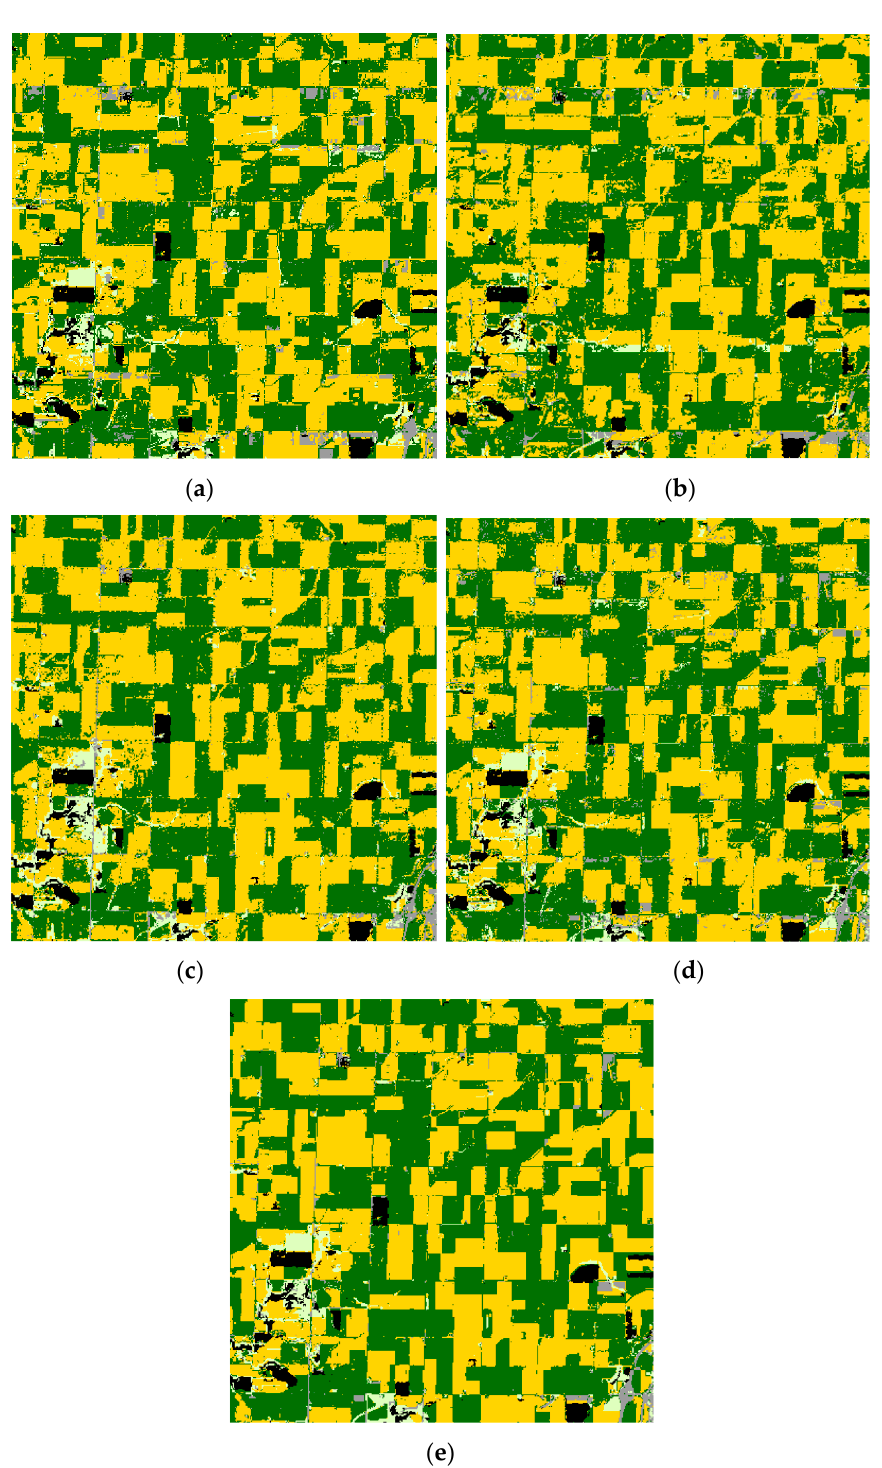
Figure 8. Illinois classification results. Green = soybeans; yellow = corn; gray = developed/open space; pale green = grass/pasture; black = background (CDL classes covering ≤ 2% of the study area). ( a ) TI.